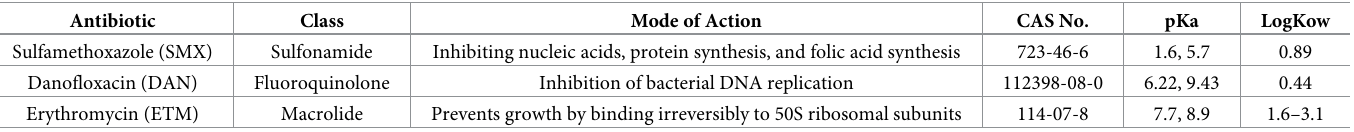
Table 2. Antibiotic information of those used in the present